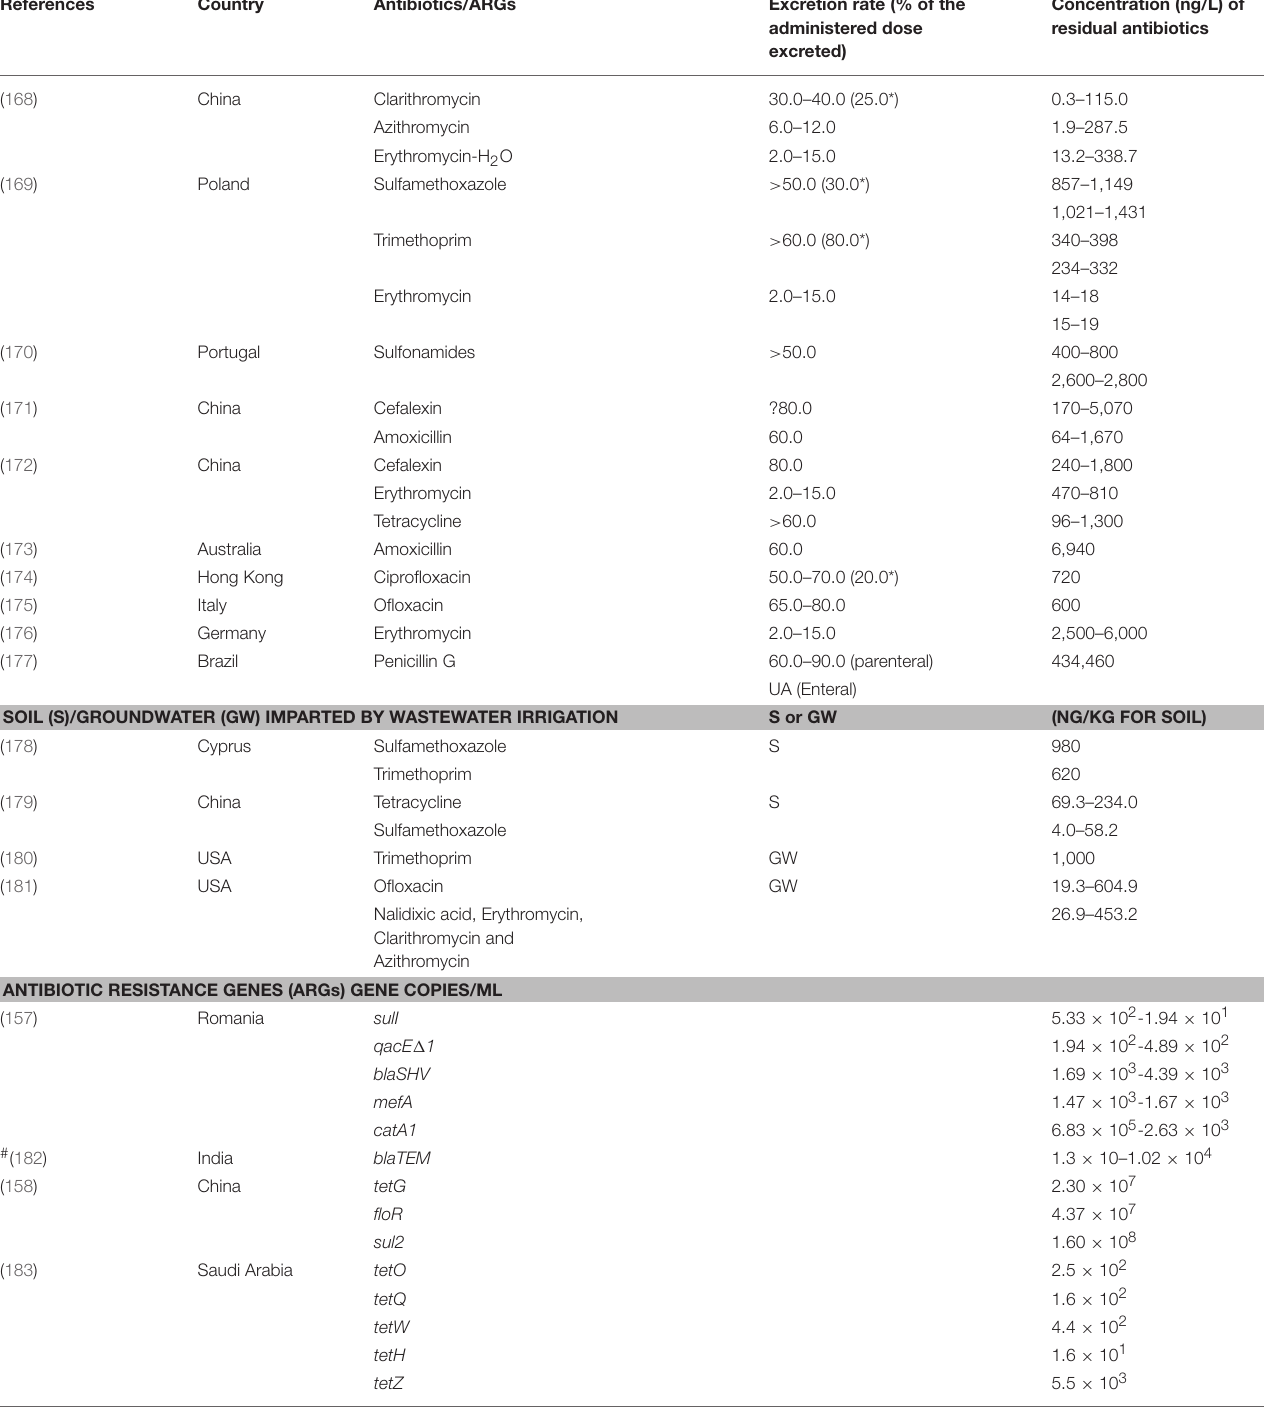
sulI gene codes for resistance against sulphonamides; qacE 1 1 gene codes for resistance against quaternary ammonium compounds; mefA gene codes for resistance against Macrolide-lincosamide-streptogramin B antibiotics; catA1 gene confers resistance to chloramphenicol. UA = unavailable; * Verlicchi et al. (184); # Measurement was in gene copies per